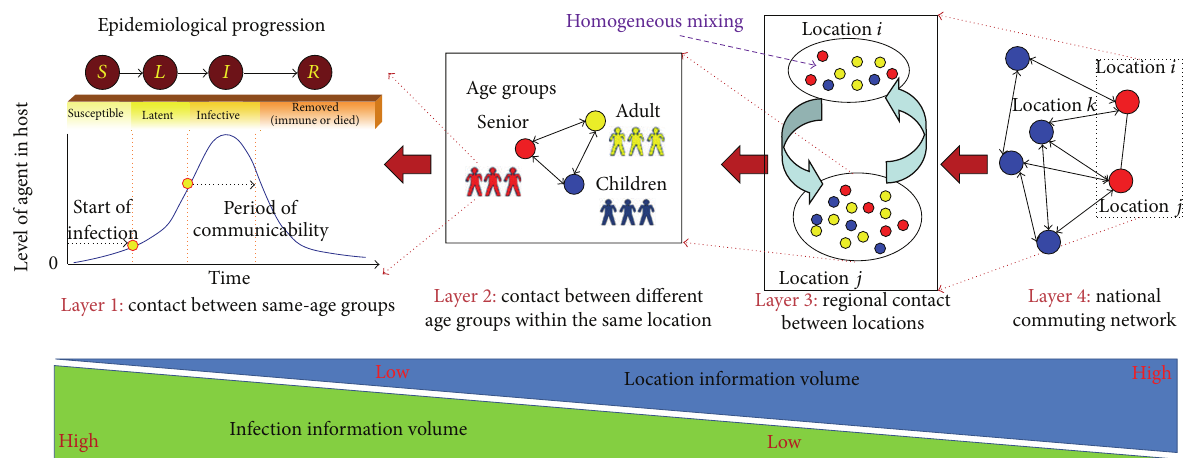
Figure 1: FLUed model framework. Infection information is highest in layer 1 and lowest in layer 4 (opposite of location information).